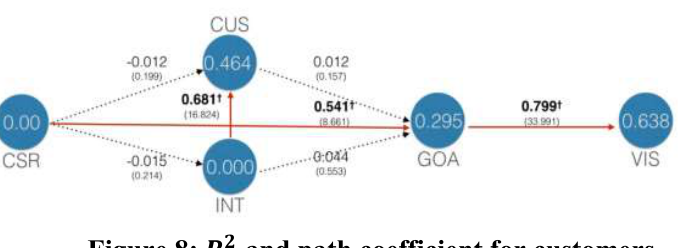
Figure 8: 𝑹 𝟐 and path coefficient for customers